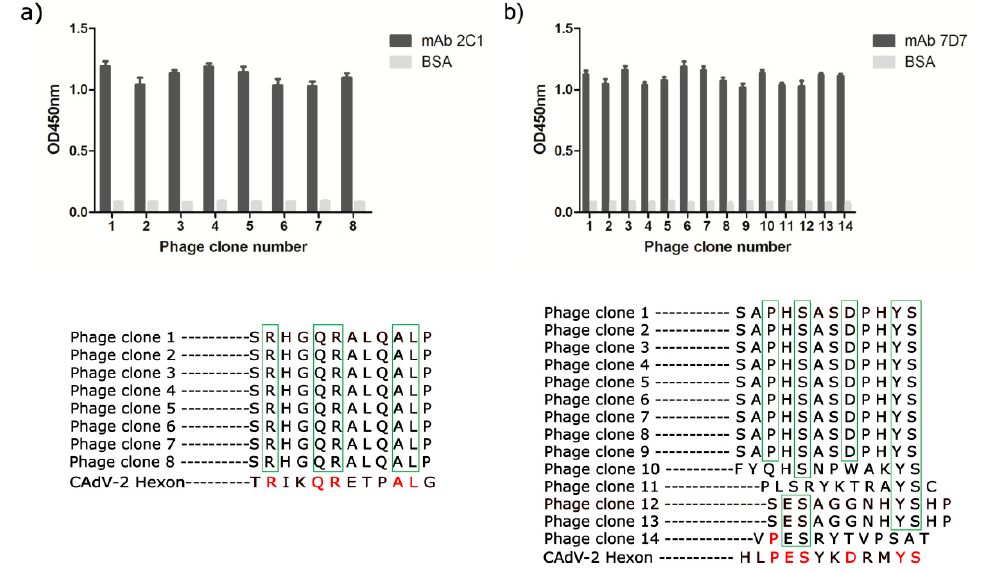
Figure 3. Confirmation of the epitope recognized by mAbs 2C1 and 7D7. Selected positive phage clones reacted specifically with mAb 2C1 and 7D7 in phage ELISA. Eight and fourteen phage clones were selected after four rounds of biopanning for ( a ) 2C1 or ( b ) 7D7, respectively, and their binding was analyzed by phage ELISA (upper). Three independent assays were carried out. Lower: sequence comparison of random peptide inserts displayed on the positive phages to the CAdV ‐ 2 sequence.